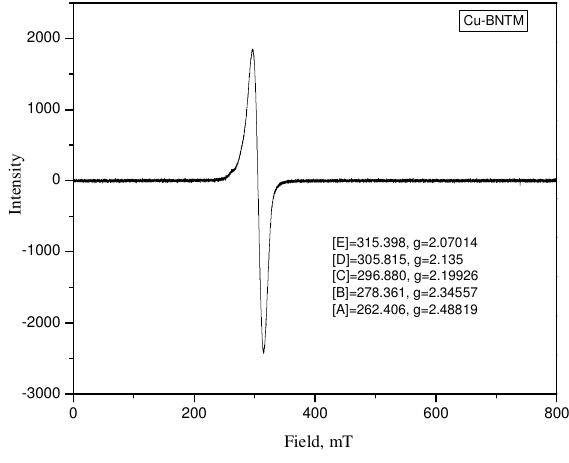
Figure 2. ESR spectrum of